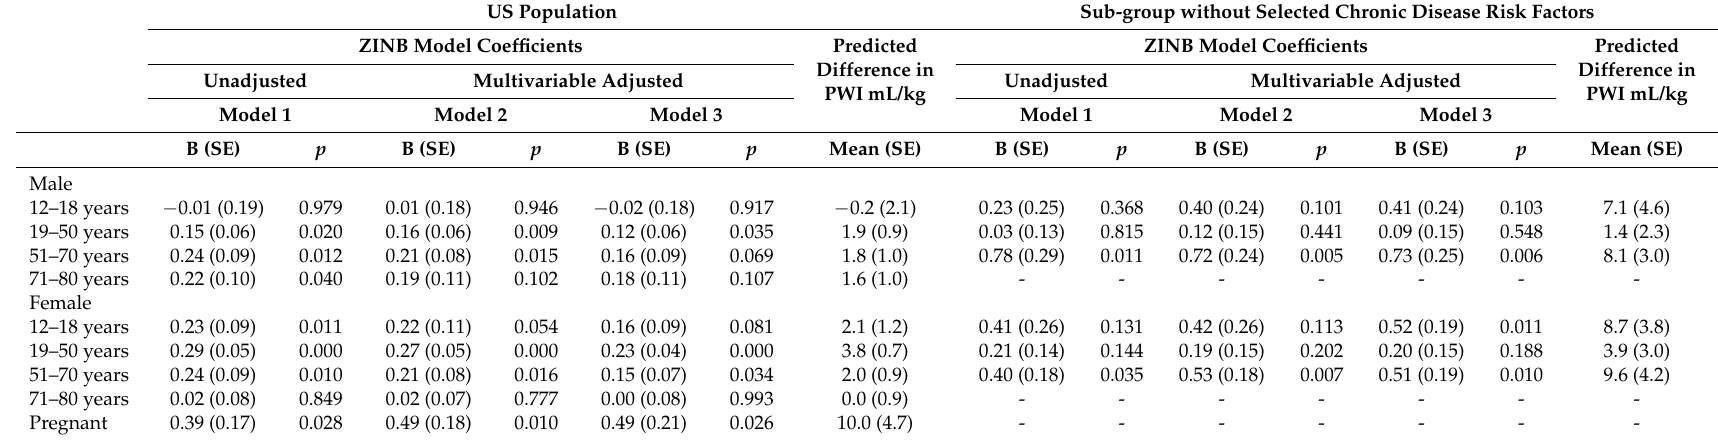
Table 7. Mean difference in PWI associated with meeting the hydration criteria versus not meeting the hydration criteria for the US population aged 12–80 years and the sub-group aged 12–70 years without selected chronic disease risk factors in